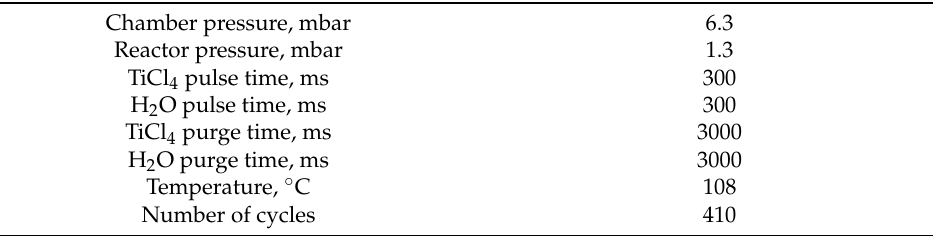
Table 2. Parameters of the atomic layer deposition.